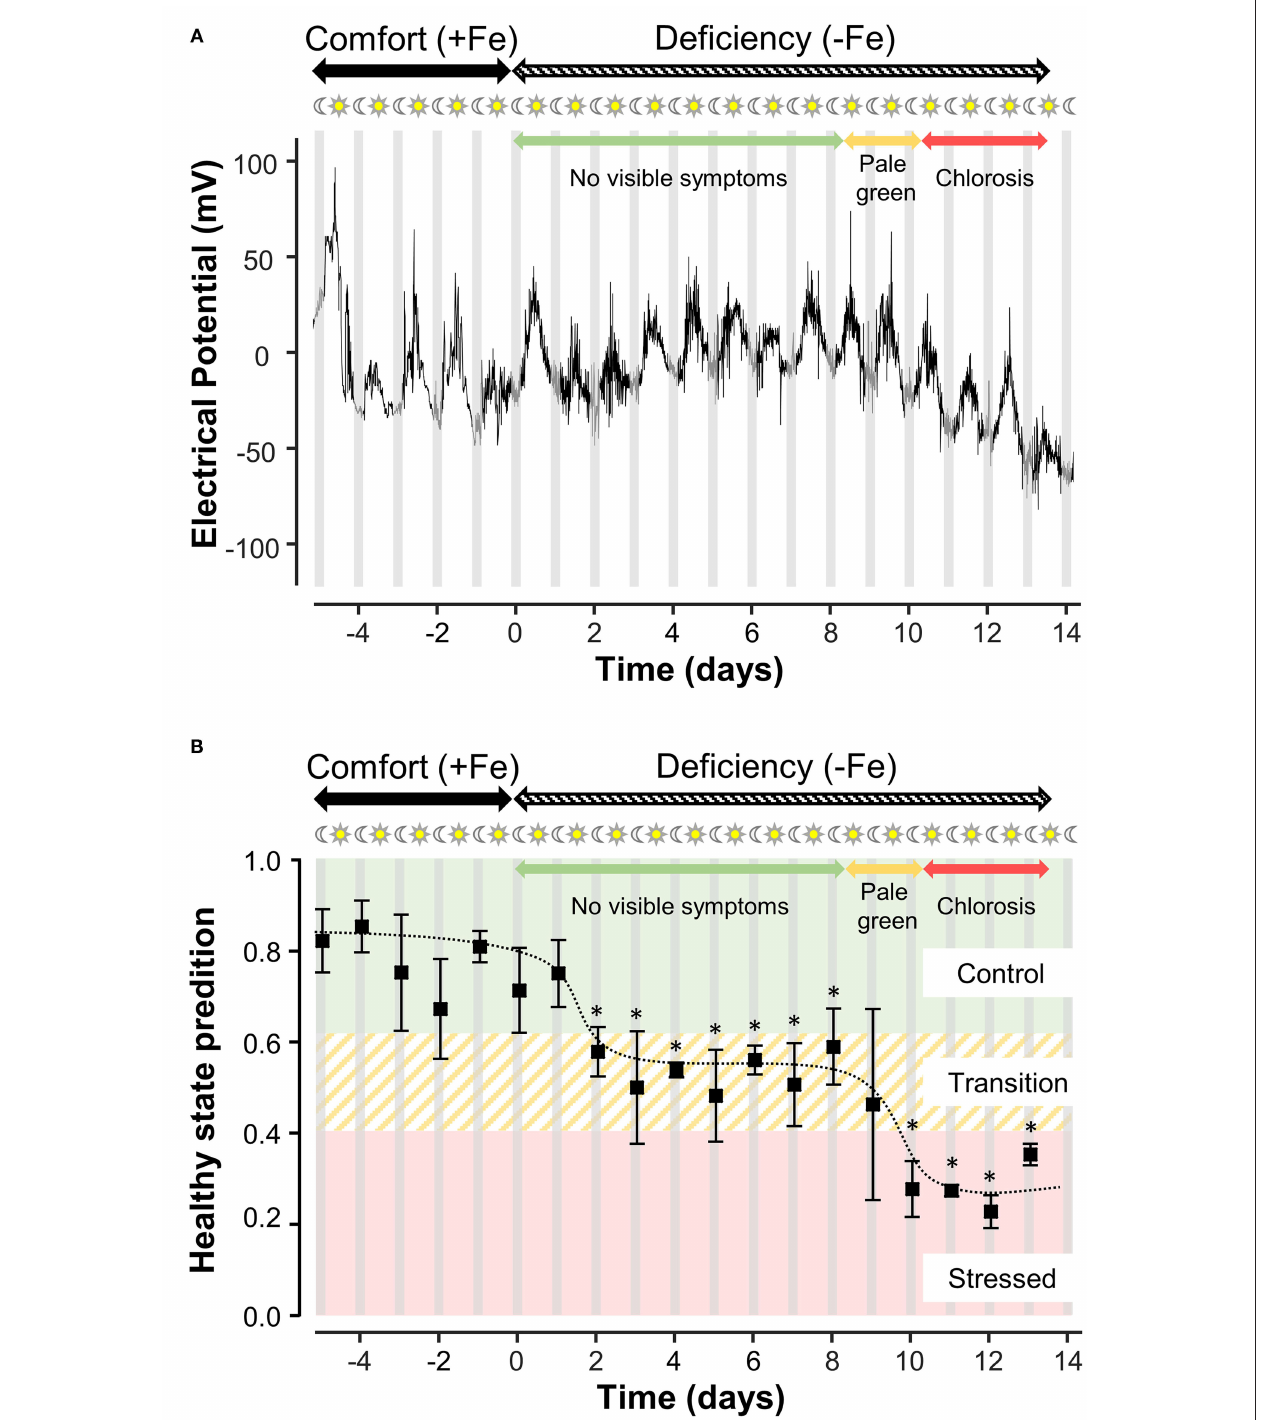
FIGURE 2 | (A) Representative long-term recording of electric potential (EP) used as the test dataset to evaluate model performance. Tomato plants were submitted to optimal nutrient condition (Comfort, + Fe) followed by iron deprivation (Deficiency, –Fe) in fertigation. Colored arrows represent different stages of visible symptoms on young leaves from non-visible ( green ) to pale green ( yellow ) then chlorosis ( red ). (B) Model prediction of healthy plant state on hydroponic tomato plants during different fertigation conditions i.e., with ( + Fe) or without (–Fe) iron. Different physiological states were defined depending on prediction rate: above 0.6, considered as control or healthy ( green ), between 0.4 and 0.6, considered as transition state from healthy to stressed ( orange ) and below 0.4 as stressed ( red ). Results represents mean ± s.e.m ( n = 3). Asterisk ( * ) indicates significantly different from comfort condition (Mann–Whitney Rank Sum Test, p < 0.05).